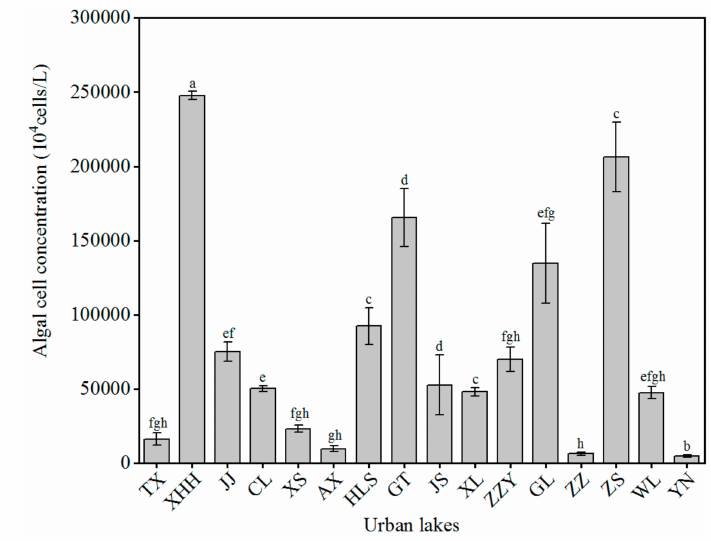
Figure 2. Algal cell concentration of 16 di ff erent urban lakes in October 2018. Bars with di ff erent upper letters are significantly di ff erent at 0.01 levels. Error bars represent standard deviations ( n =